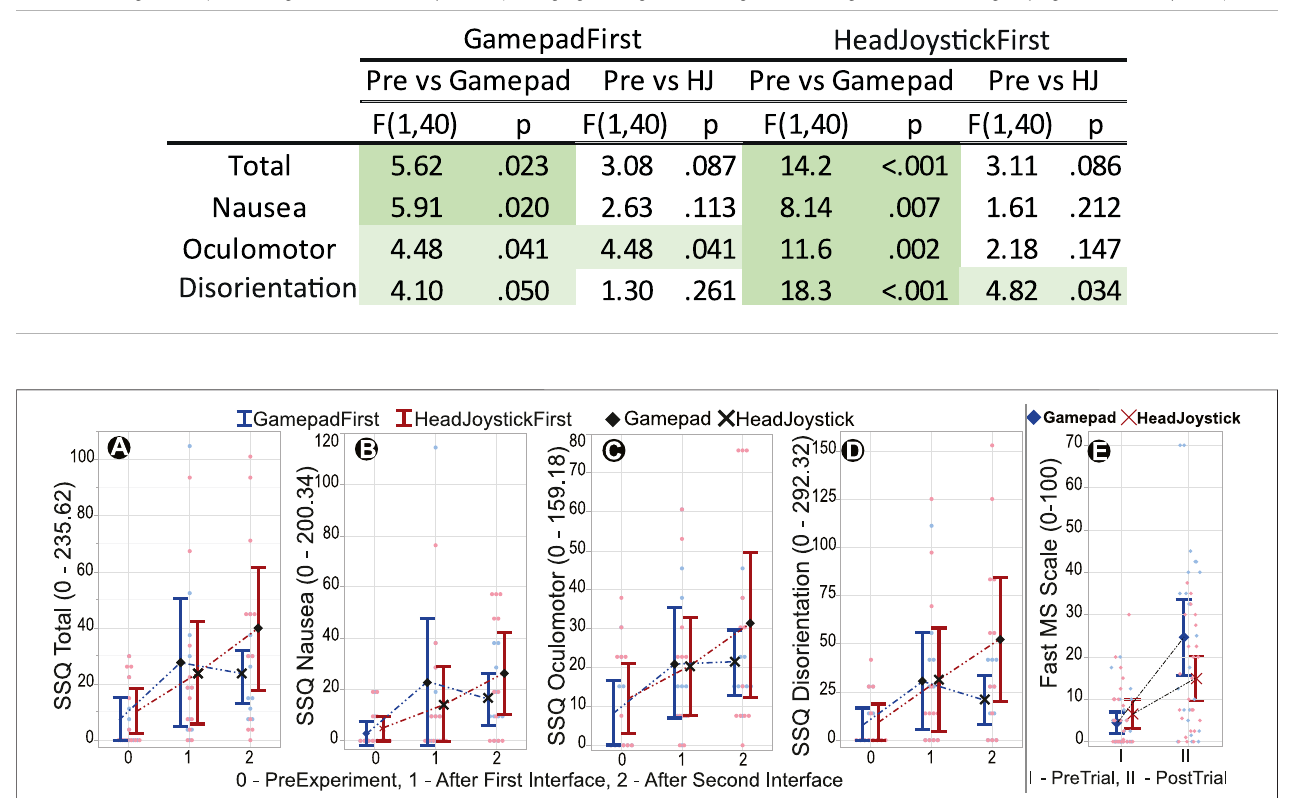
FIGURE7| User ’ sself-reportofmotionsicknessusingSSQquestionnairebeforetheexperimentstarted( “ Pre-Experiment ” ),afterusingthe fi rstinterface,andafter using the second interface. Blue and red lines indicate an average participant using Gamepad and HeadJoystick as their fi rst interface respectively. A (cid:2) Gamepad interface, X (cid:2) HeadJoystick interface, CI (cid:2) 95%.